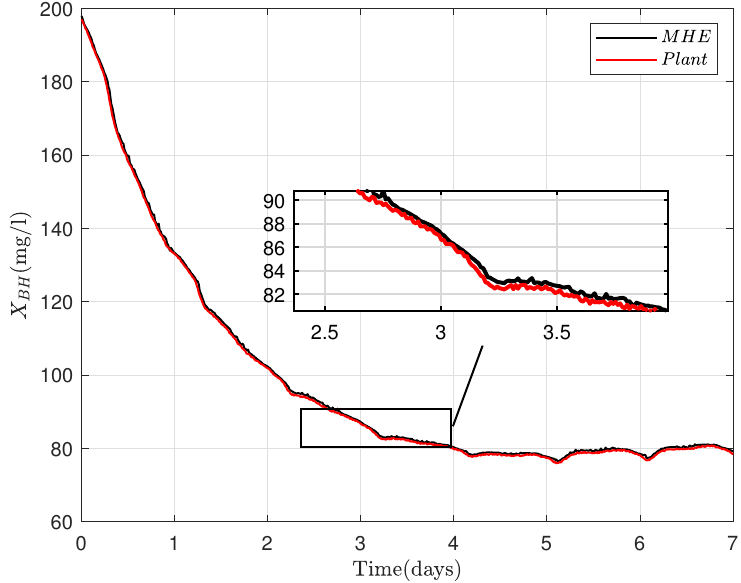
Figure 4. MHE estimate of heterotrophic biomass ( X BH ) for 7